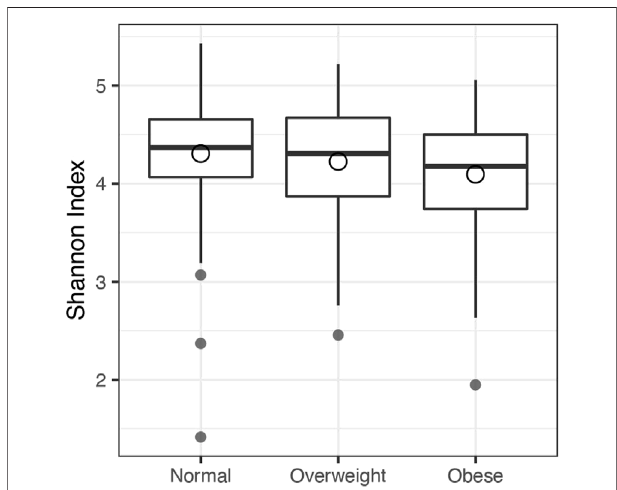
FIGURE 3 | The boxplot of Shannon index across BMI categories in United Kingdom twins study. Normal: BMI < 25; Overweight: 25 ≤ BMI < 30; Obese: BMI ≥ 30. The circle on each box denotes the mean of Shannon Index in that category.